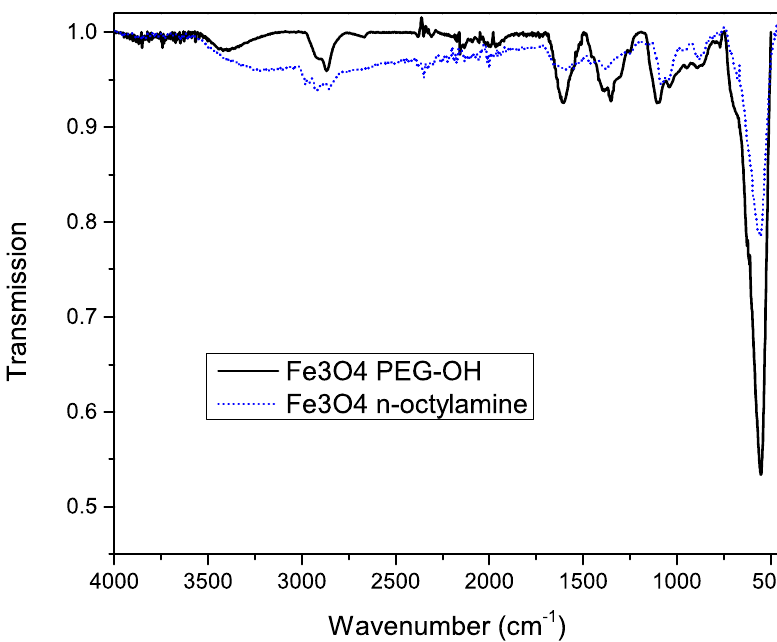
Figure 4. Infrared spectrum of iron oxide nanoparticles before (dotted blue line) and after (solid black line) functionalization with silane-PEG-OH molecules.